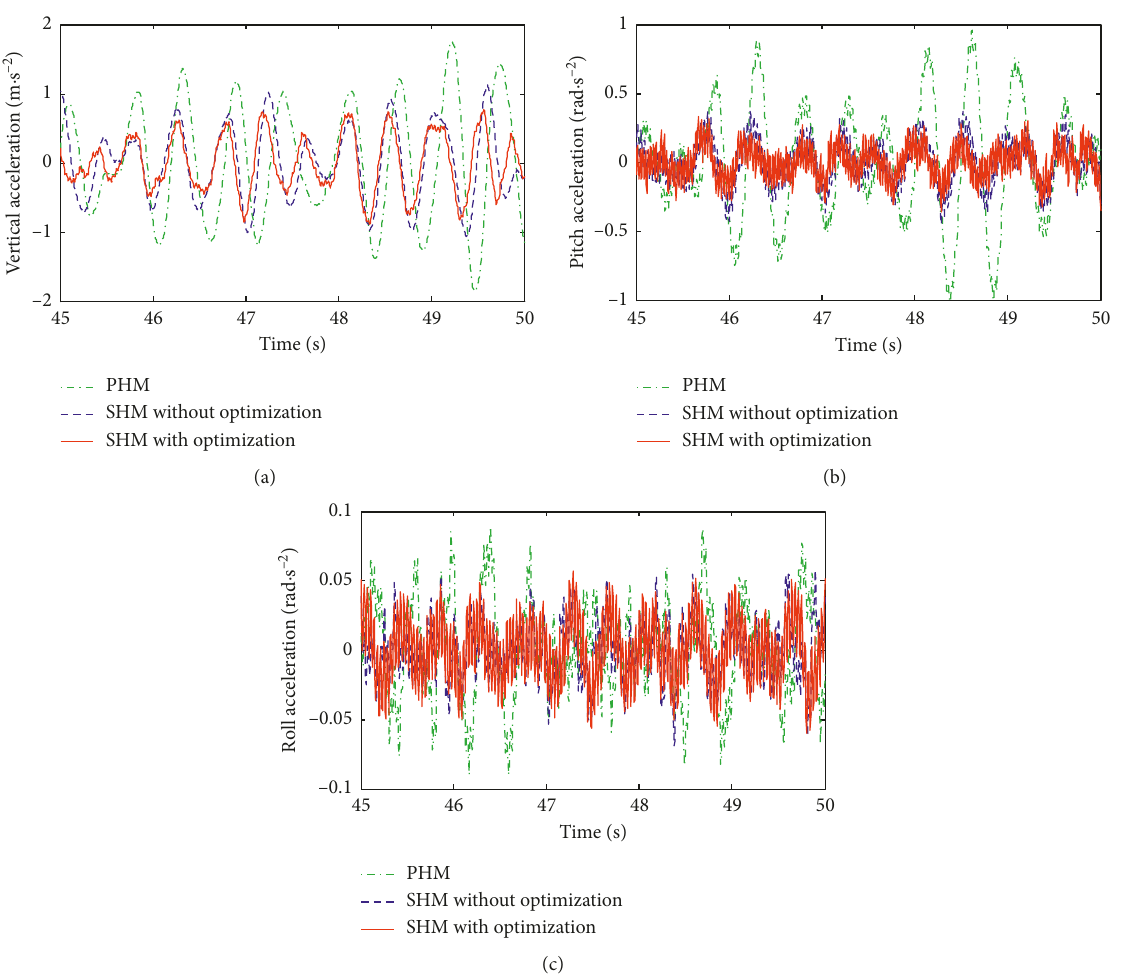
Figure 12: Results of the acceleration responses under a low excitation frequency, 28Hz, of the drum. (a) Vertical driver’s seat. (b) Cab’s pitch angle. (c) Cab’s roll